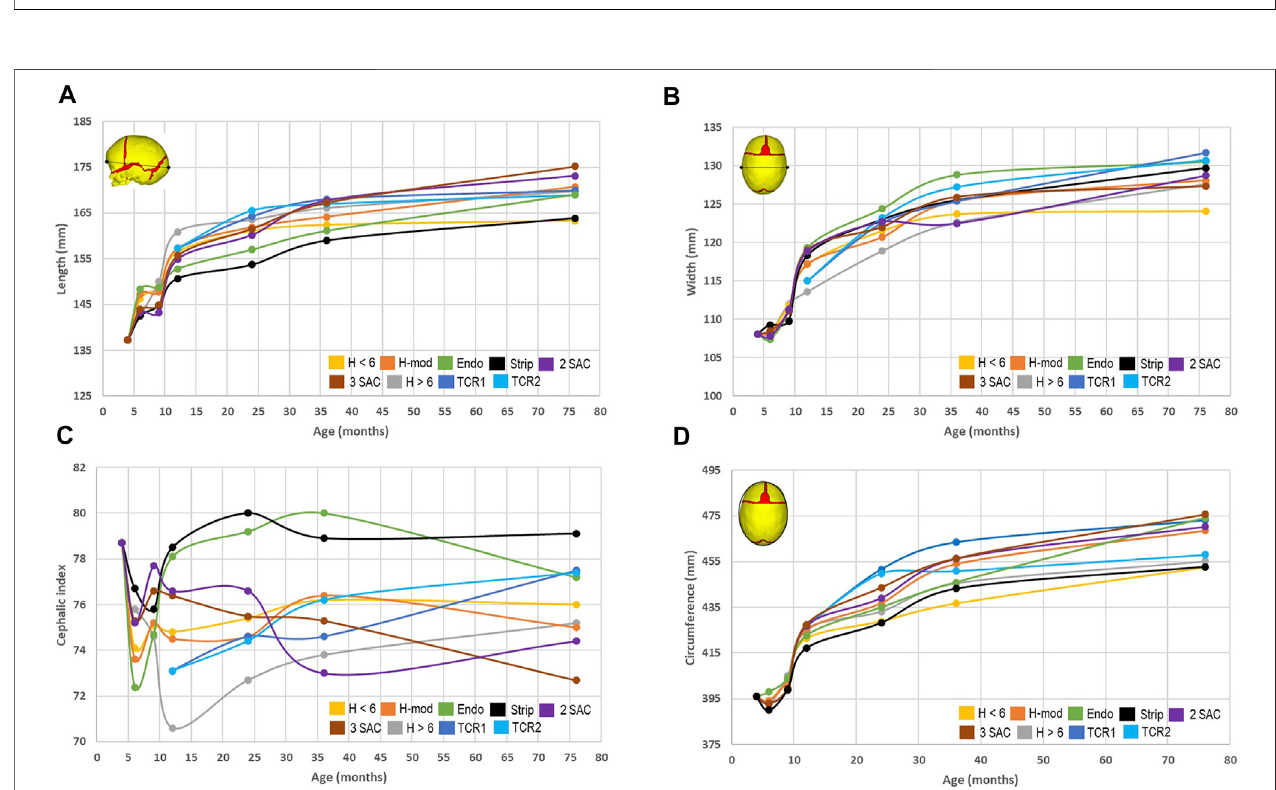
FIGURE 3 | Cephalometric measurements across all replicated approaches. The predicted length (A) and width (B) were used to calculate the cephalic index (C) . The circumference (D) was measured in the transverse plane as shown within the diagram.